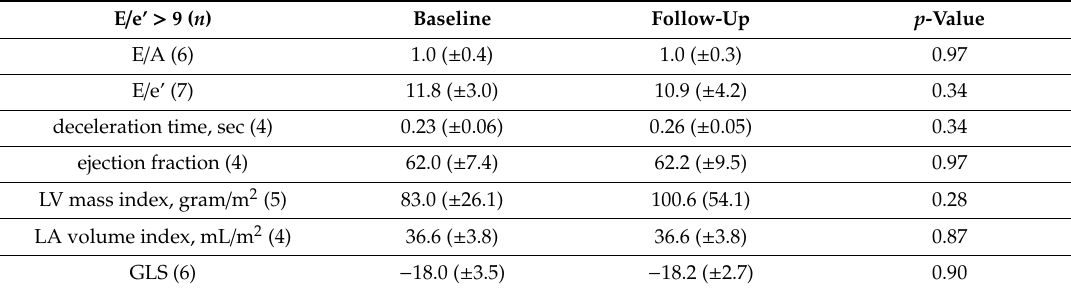
Table 3. E ff ect of anti-TNF in patients in the highest E / e’ quartile (E / e’ >